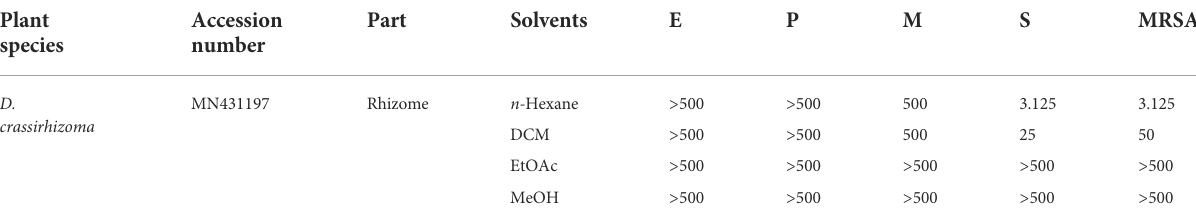
TABLE 1 Antimicrobial screening of crude D. crassirhizoma , given as minimum inhibitory concentrations [MICs] µg/mL. Plant species